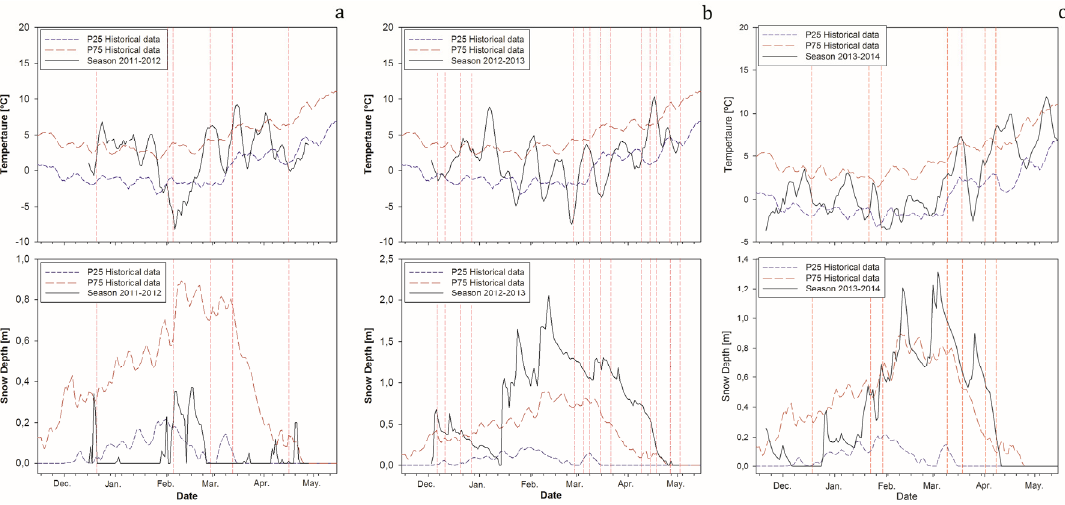
Figure 3. Temperature (up) and snow depth (down) for the 2011–2012 ( a ); 2012–2013 ( b ) and 2013–2014 ( c ) snow seasons. The red vertical dashed lines show the TLS acquisition dates.